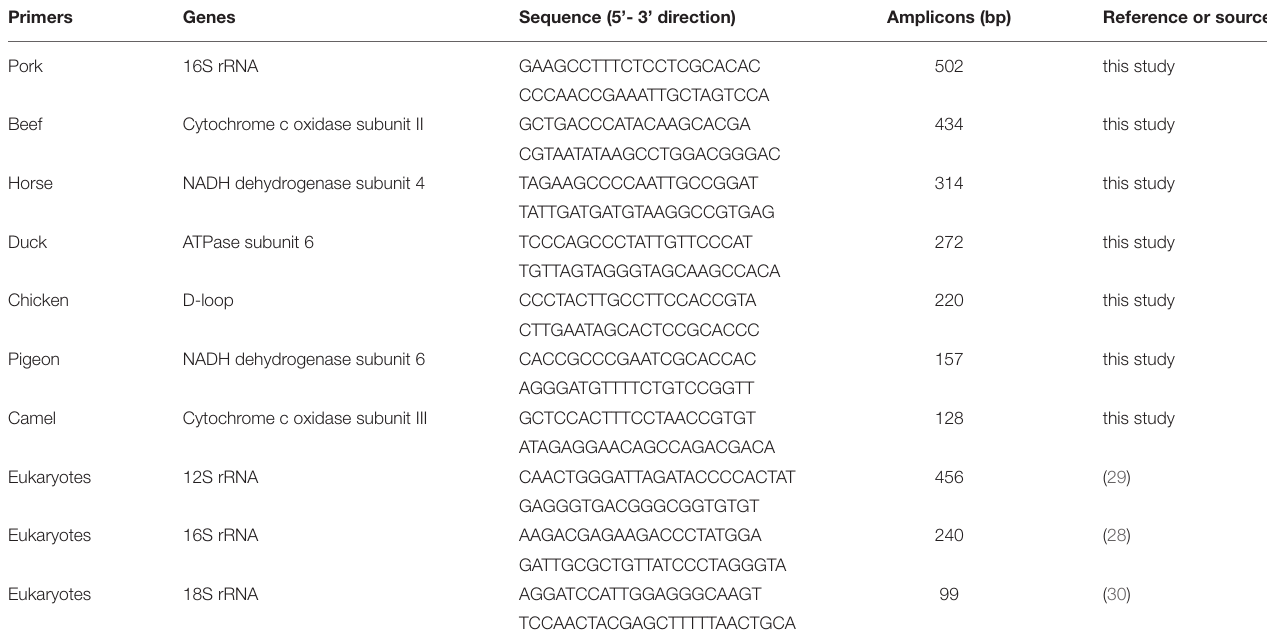
TABLE 1 | Oligonucleotide primers for meat species used in this study.